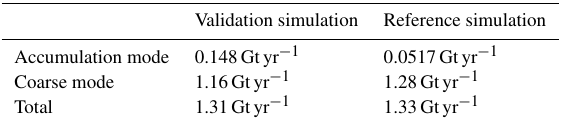
Table 3. Global mineral dust emissions in 2011 obtained by